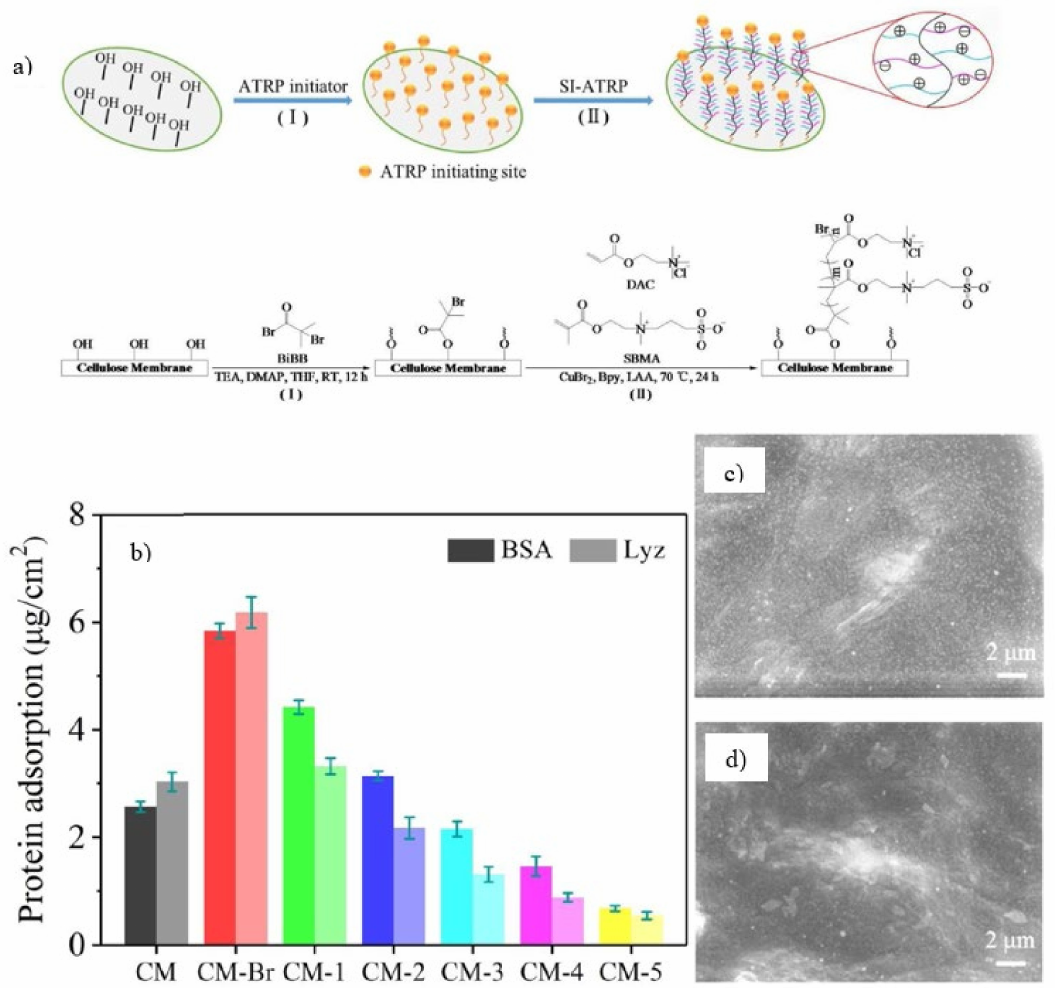
Figure 7. ( a ) Schematic illustration of SI-ATRP synthesis of zwitterion and quaternary ammonium copolymers from cellulose membrane; ( b ) Adsorption of BSA and Lyz on the cellulose membranes. SEM images represent the morphologies of BSA on the surface of ( c ) pristine cellulose membrane (CM); ( d ) modified CM-5 (CM = Unmodified membrane, CM (1–5) = Grafted membrane with various grafting degree and grafting ratio in which CM5 uses highest grafting degree and ratio)